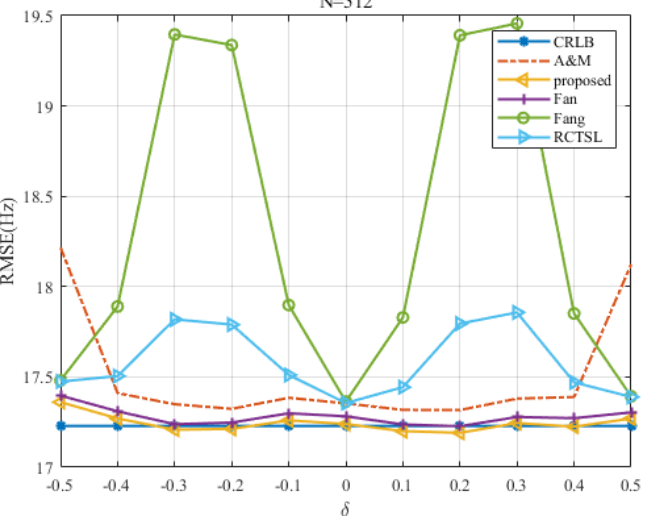
Figure 12. RMSE comparison among the frequency estimates versus δ at N = 512 and SNR = 0